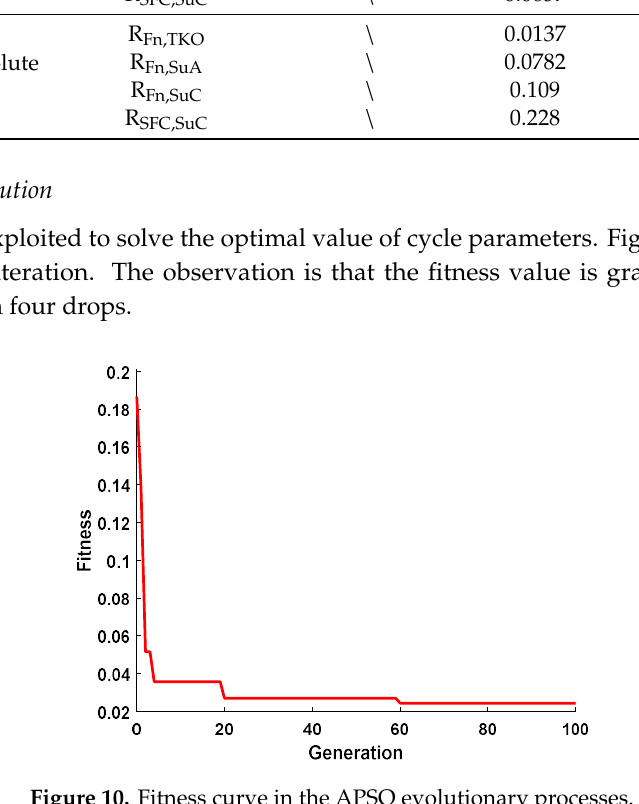
Figure 10. Fitness curve in the APSO evolutionary processes.